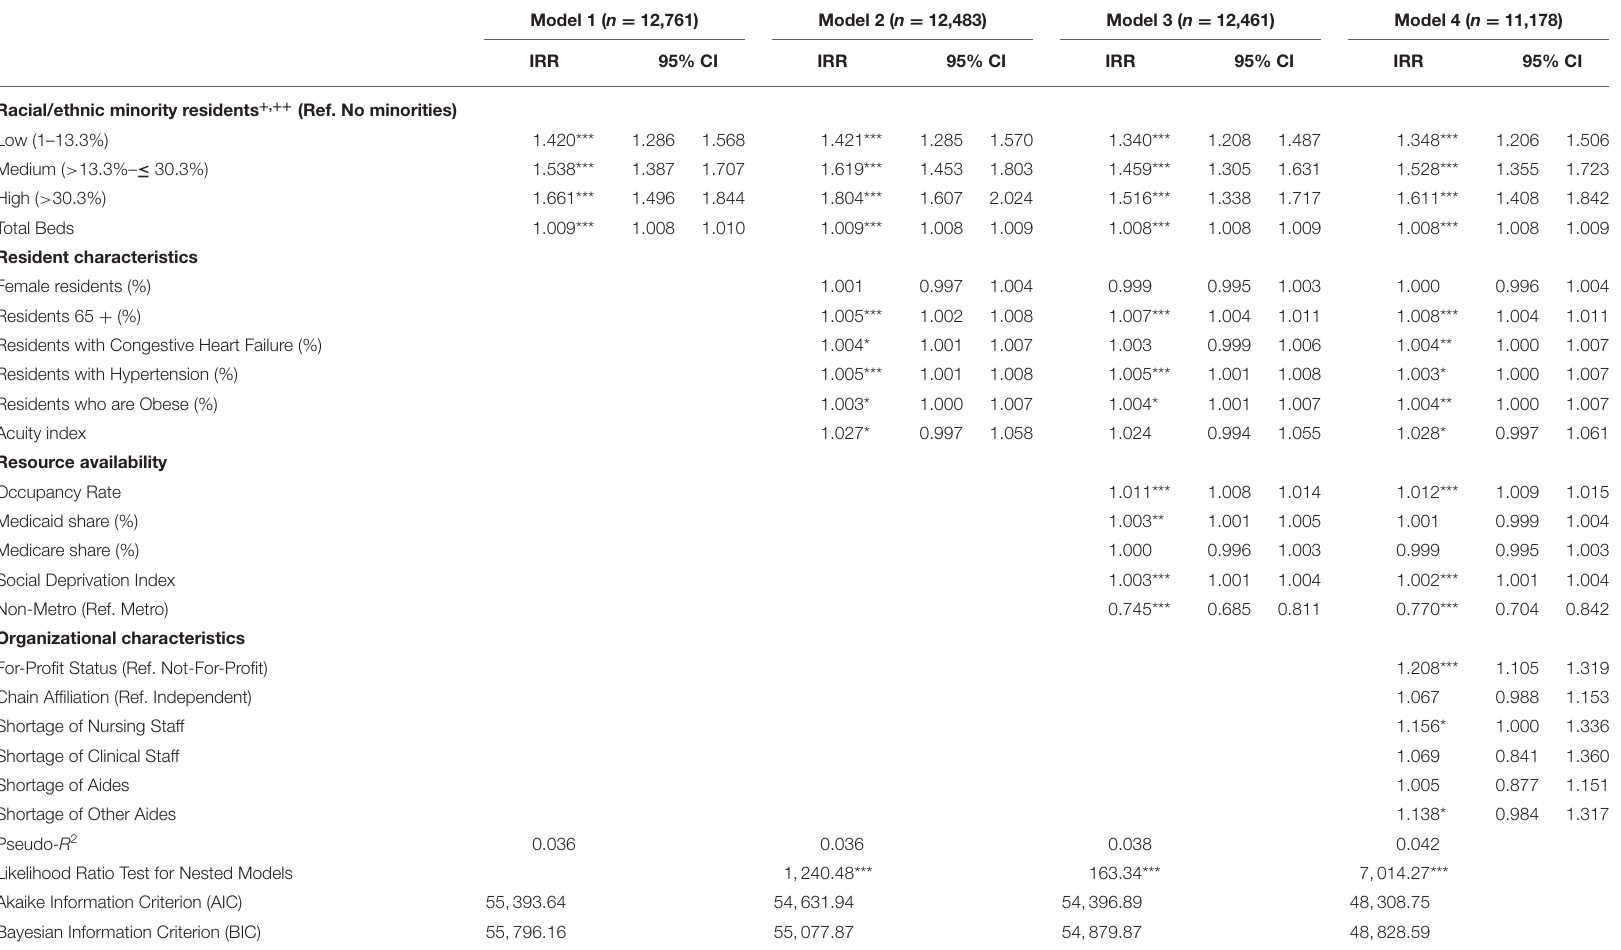
TABLE 2 | Negative binomial regression results for incidence rate ratios (IRR) of COVID-19 deaths in nursing